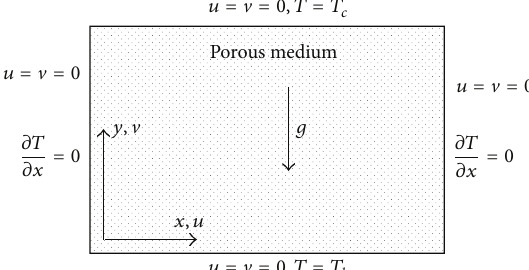
Figure 1: Schematic view of the computational